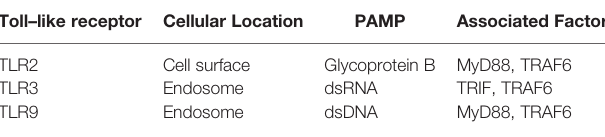
TABLE 2 | Toll – Like Receptors Activated During HSV – 1